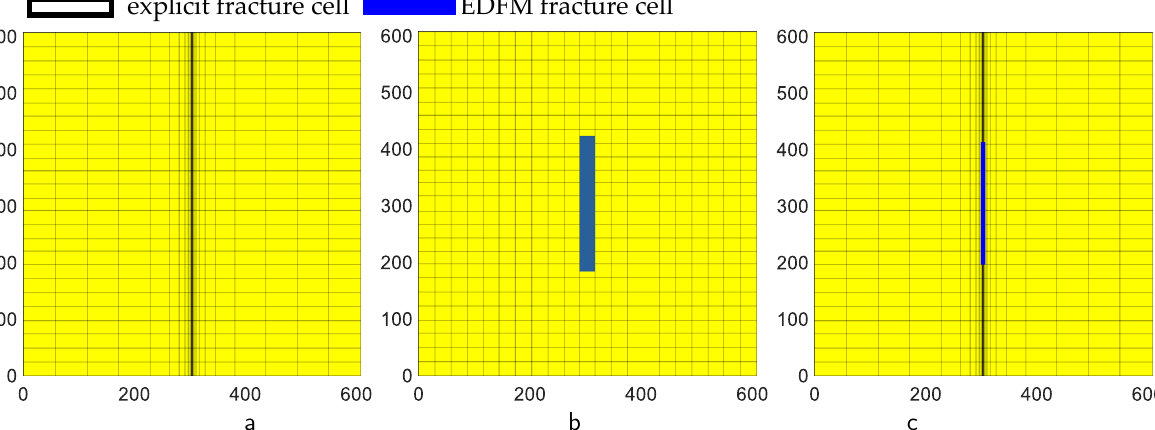
Figure 12. Grids for VE1B sensitivity analysis simulations: ( a ) Local Grid Refinement (LGR), ( b ) EDFM, ( c ) LGR+EDFM; the fracture cell is magnified 10 times.